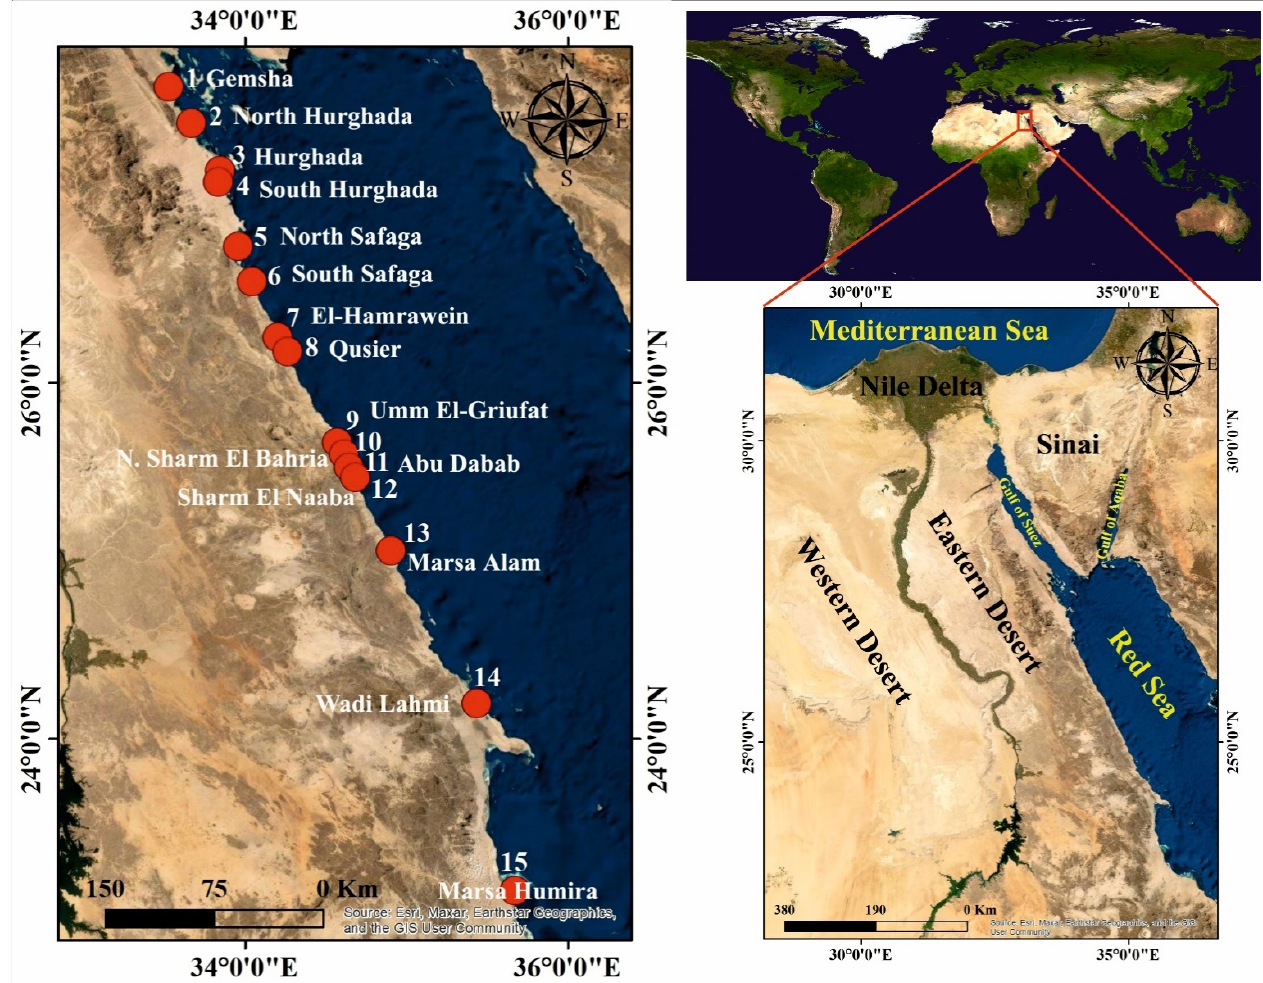
Figure 1. Map displaying the study area and sampling